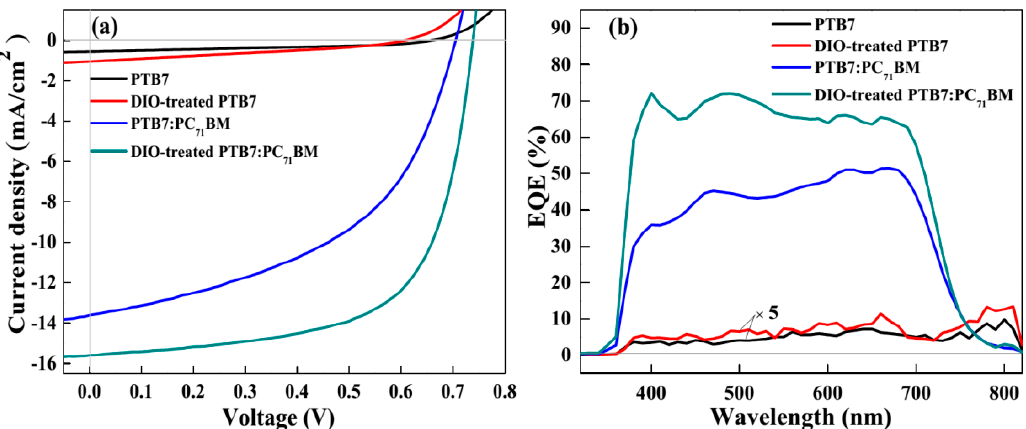
Figure 2. ( a ) J-V curves of PSCs based on varied active layers under the illumination of AM 1.5 G (100